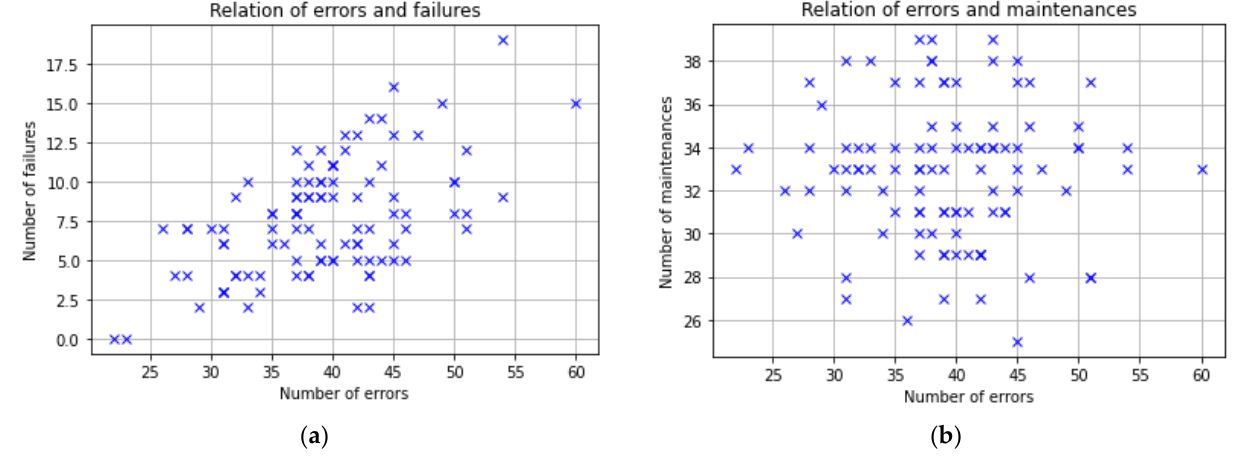
Figure 7. Relation between error statements, failures, and maintenance count. ( a ) The number of failures; ( b ) the number of maintenances.